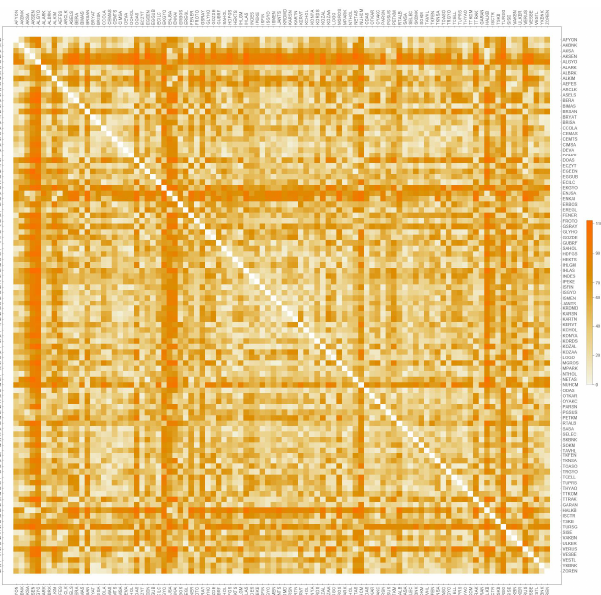
Figure 2. Intra-sectorial similarities of fractal dimensions measured by DTW (after pandemic).